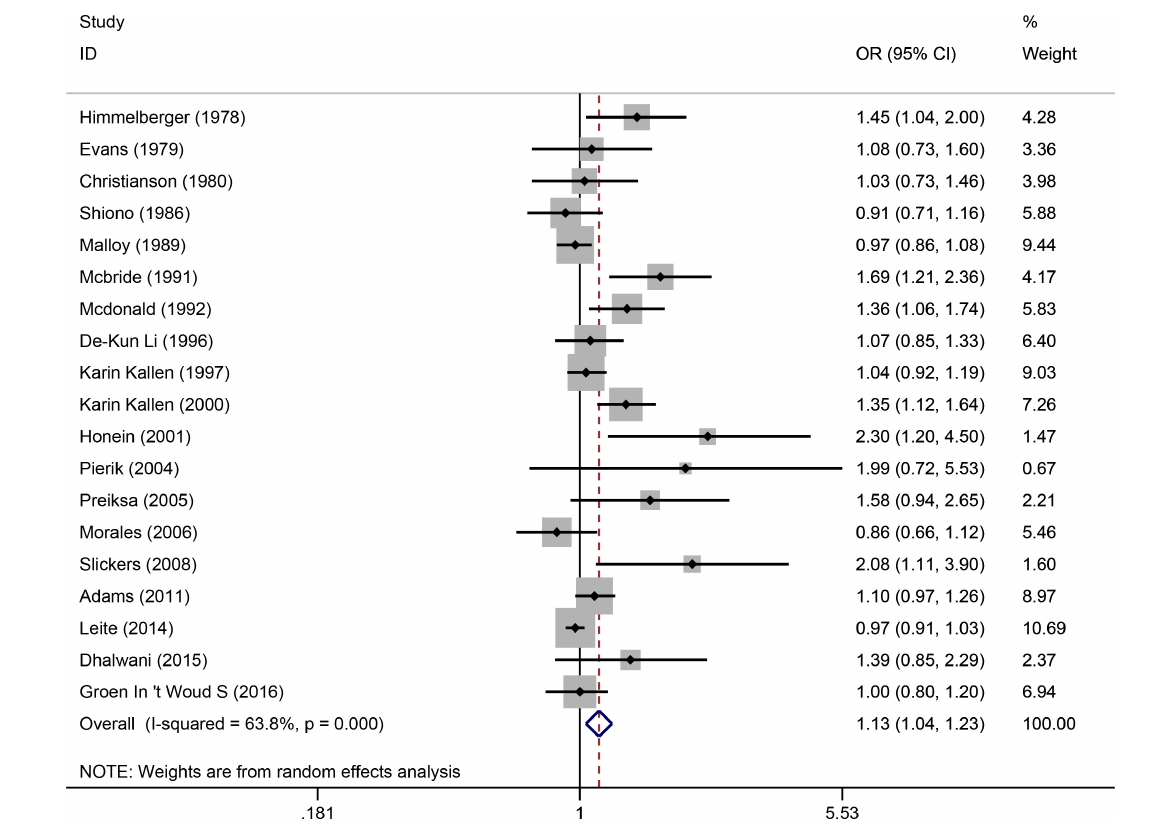
FIGURE2 Forest plot for the relationship between maternal smoking during pregnancy and the risk of congenital urogenital malformations. Studies are sorted according to the sequence of publication